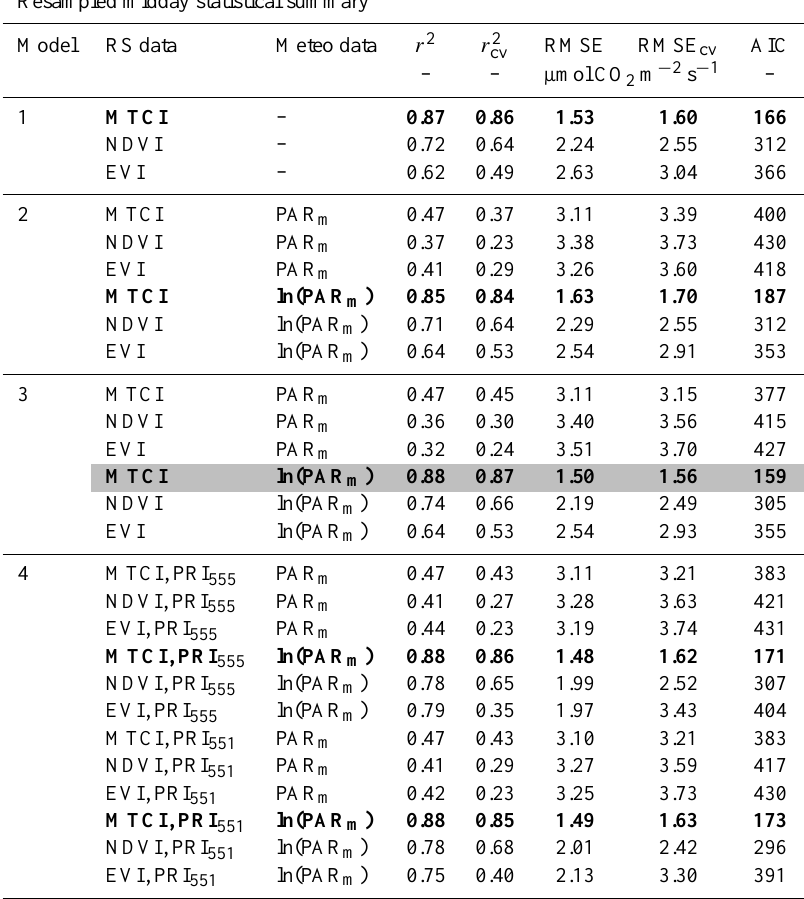
Table 5. Summary of statistics in fitting ( r 2 and RMSE) and cross-validation ( r 2 cv , RMSE cv and AIC) of different models tested in this study using average GPP m and PAR m data and resampled VI time series. The best-performing models in each class are in bold print. The most successful of all models is grey